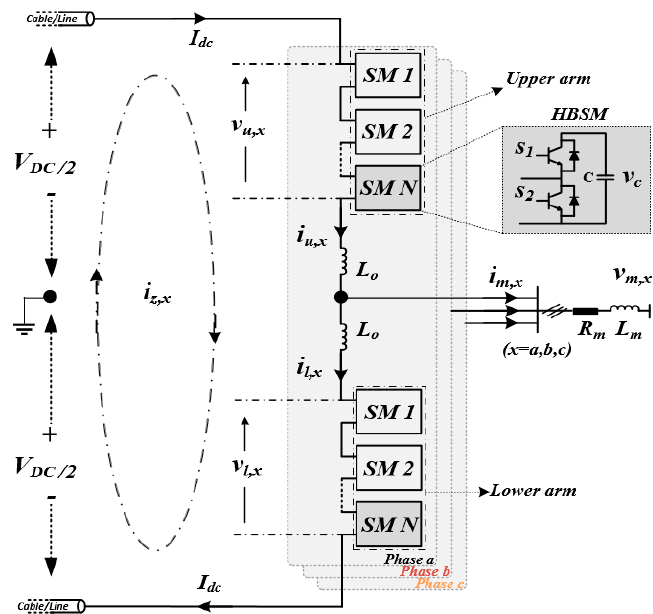
Figure 1. Three-phase MMC circuit with HBSM configuration.